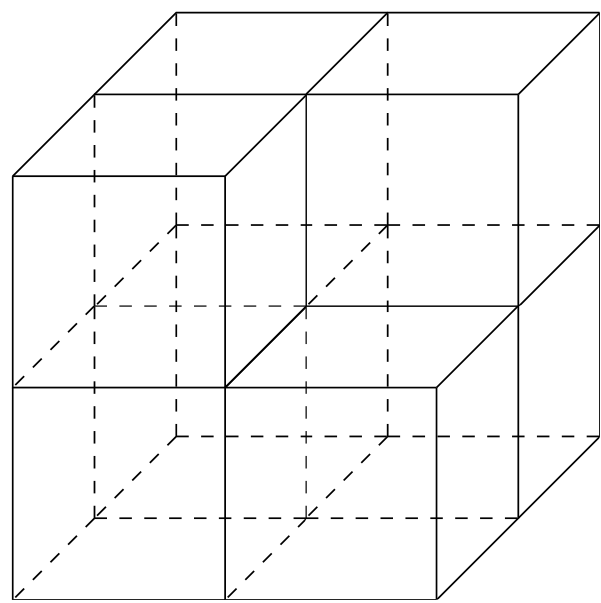
Figure 4. A cubical complex built out of seven 3-cubes.